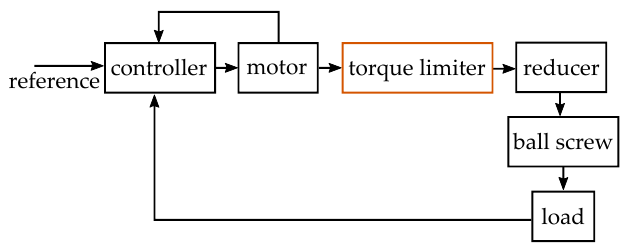
Figure 2. Typical block diagram of aerospace